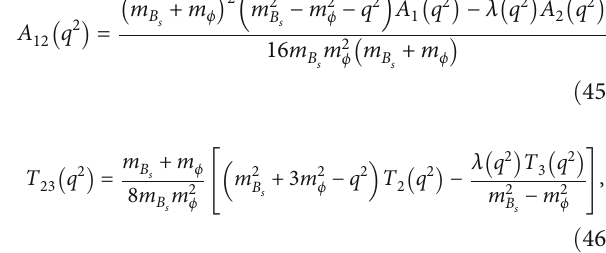
Table 3: The central values of the theoretical predictions for the form factors of B models [17, 20, 21, 23, 42, 85 –